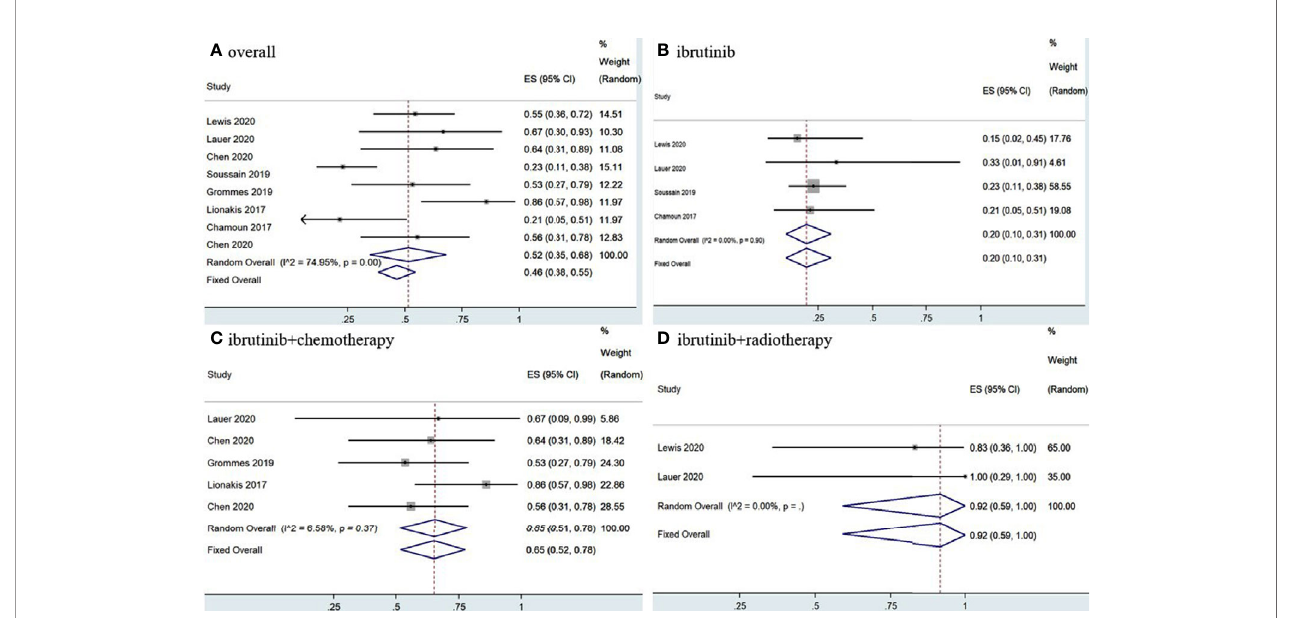
FIGURE 3 | Pooled complete response rates of central nervous system lymphoma. (A) Ibrutinib-based regimens. (B) Ibrutinib monotherapy. (C) Ibrutinib combined with chemotherapy. (D) Ibrutinib combined with